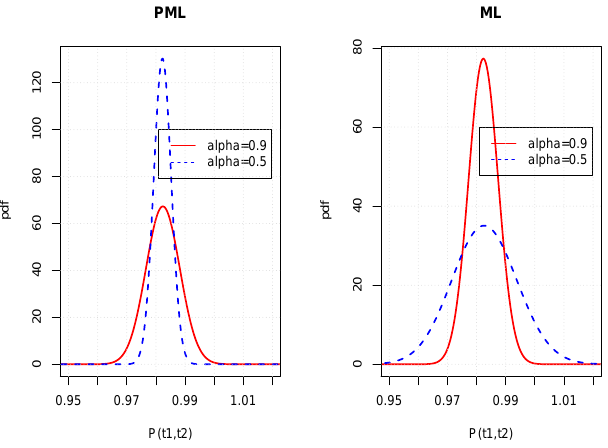
Figure 9. Probability density function of P ( n ) ( 5,10 ) under the forward measure of numeraire P ( n ) ( 0,5 ) , α = 0.5 and 0.9; β = 1.5; λ 1 = 0.5; η 1 = − 0.002; σ 1 = 0.01. ML and PML kernels with n = 40